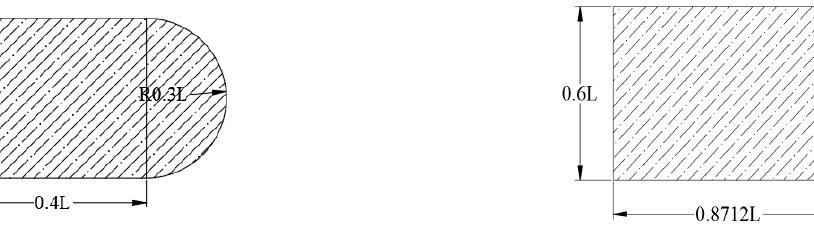
Figure 2. Equivalent wheel imprint area of the rectangle, combined with the wheel imprints.